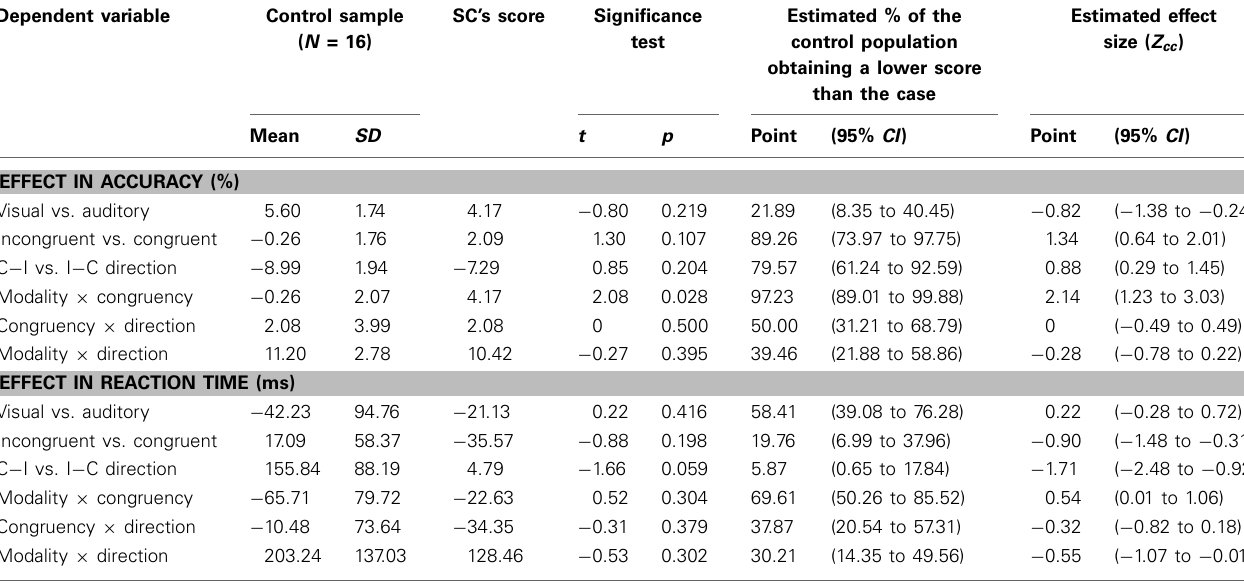
Table 3 | Differences in performance on the priming between SC and controls for main effects and 2 × 2 interactions.